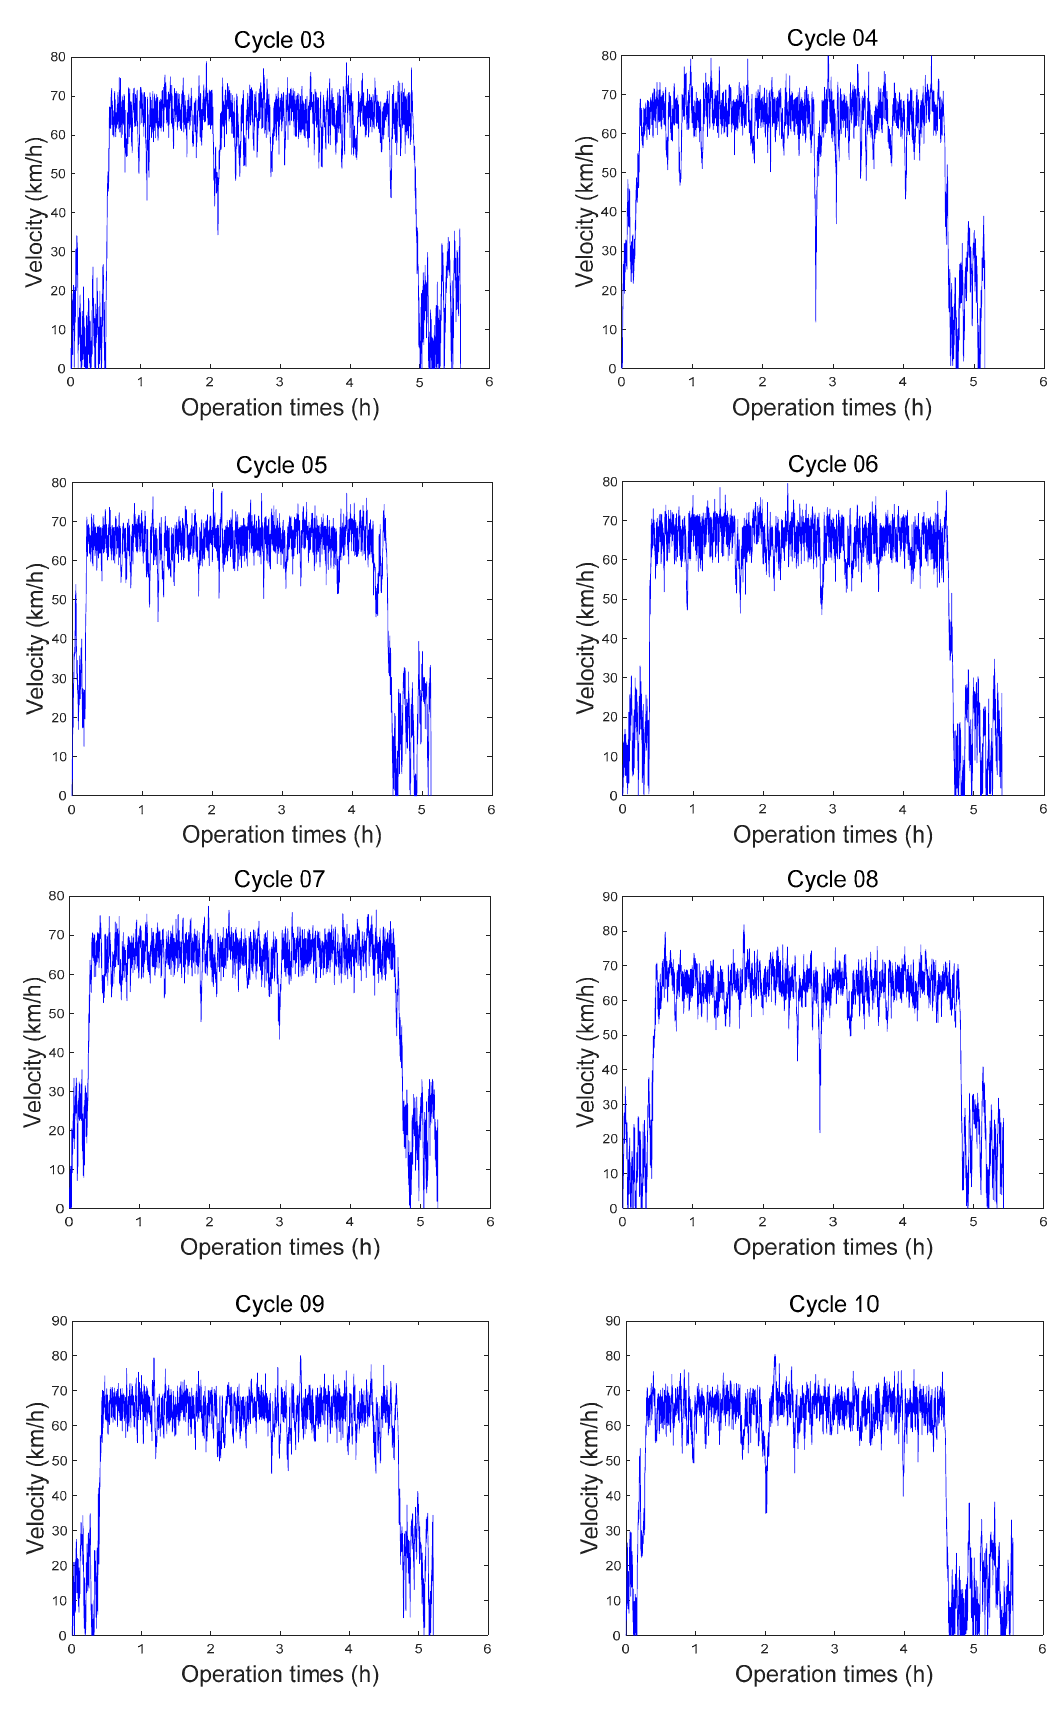
Figure 8. 10 target driving cycles generated by Markov chain.